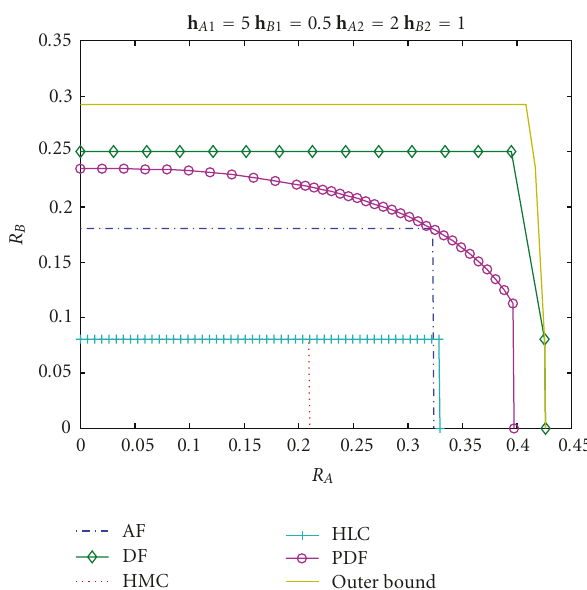
Figure 8: The achievable rate regions and the outer bound.